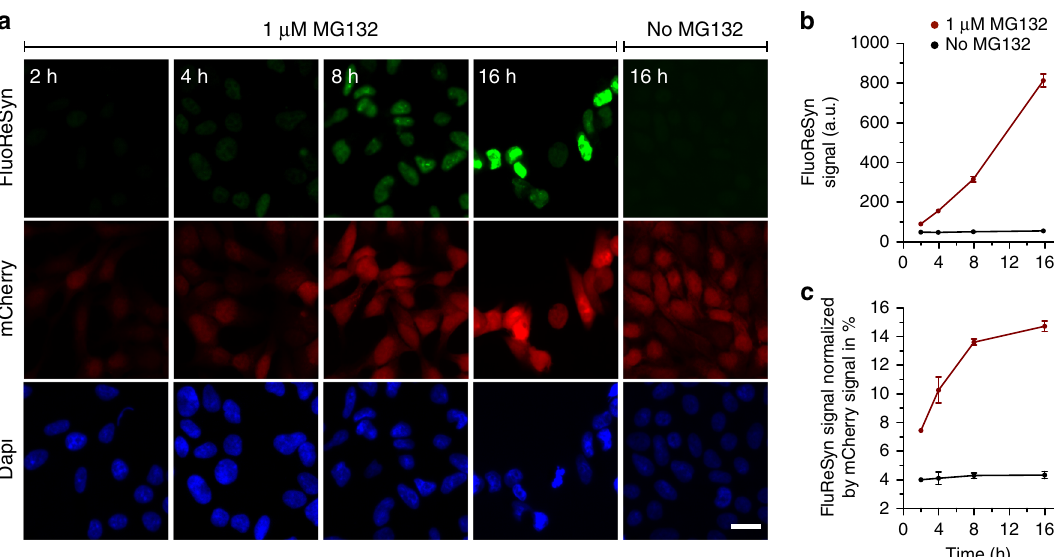
Fig. 2 The FluoReSyn is rapidly degraded by the proteasome machinery. a Equally scaled, representative epi fl uorescence images of MG132 treated and untreated Reporter-cells which were fi xed 2, 4, 8, or 16 h post treatment. The FluoReSyn accumulates in response to prolonged MG132 treatment of Reporter-cells as revealed by the increasing nuclear EGFP intensity. Reporter-cells untreated with MG132 yielded virtually no EGFP signal even after 16 h. Scale bar represents 20 µ m. b Quantitative analyses of FluoReSyn signal (EGFP) in arbitrary units (a.u.) when Reporter-cells were treated or untreated with MG132. Per replication and condition more than 540 cells were analyzed. c FluoReSyn signal normalized by mCherry signal (EGFP to mCherry signal intensity). Error bars represent the SEM from three independent experiments ( n = 3). Source data is available as a Source data fi